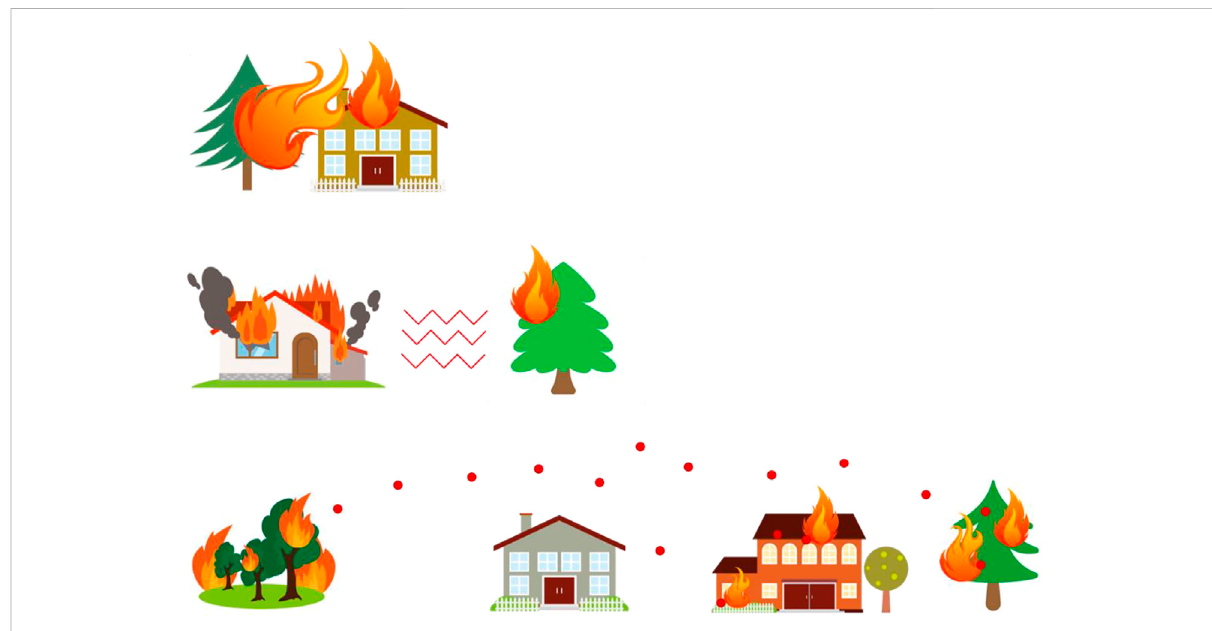
FIGURE 4 Schematic of fi re spread mechanisms in large outdoor fi res (Top: Direct fl ame contact, middle: thermal radiation, bottom: fi